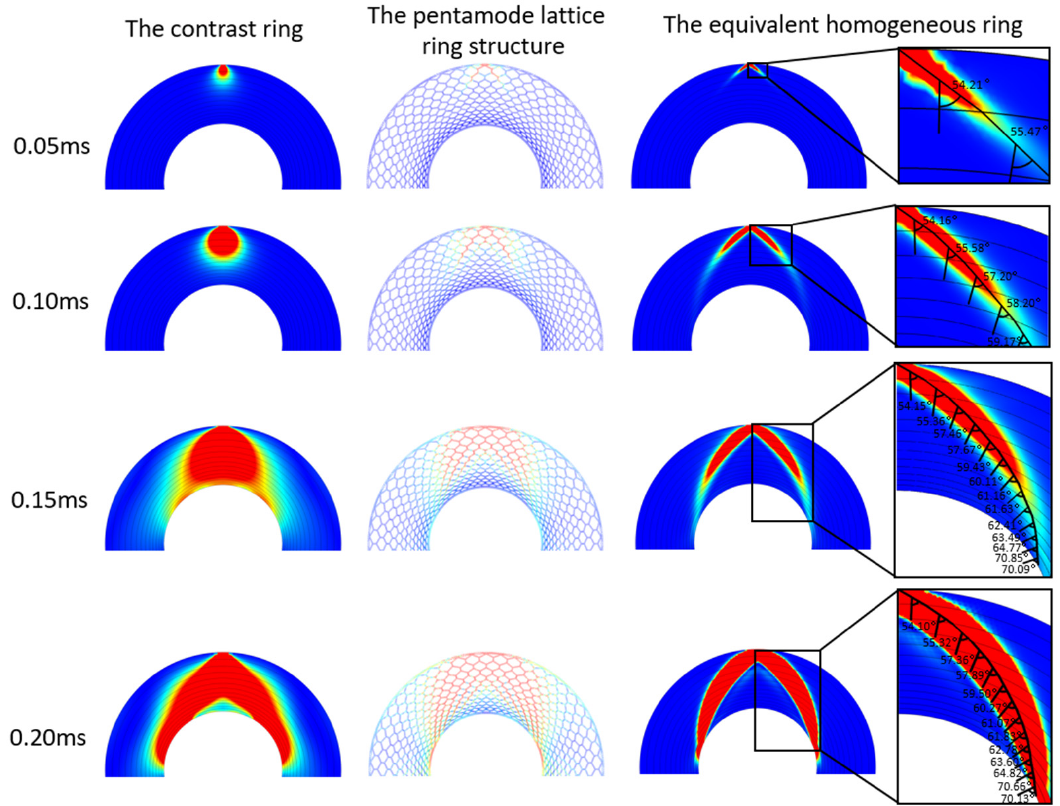
Figure 12. Energy-flow characteristics of ring structures.